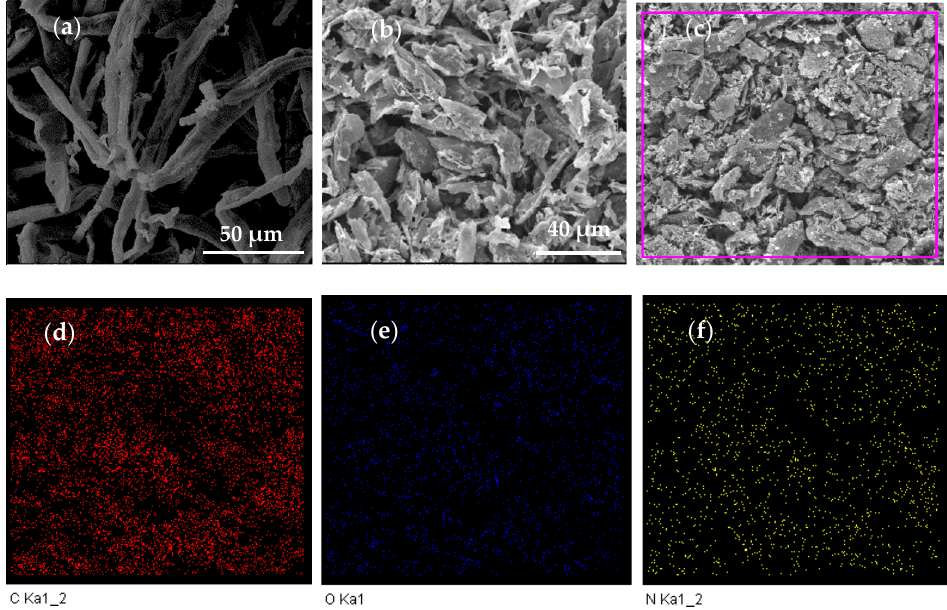
Figure 1. SEM images of ( a ) PPB-750, ( b ) N-PPB750, ( c ) selected area of N-PPB750 (red box) for EDS elemental mapping and EDS elemental mapping of ( d ) C, ( e ) O, ( f ) N.